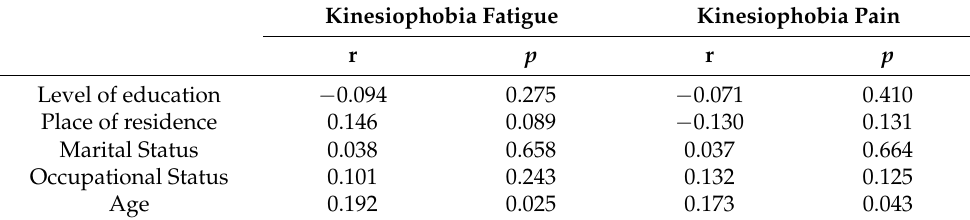
Table 8. Correlation of kinesiophobia scores with sociodemographic